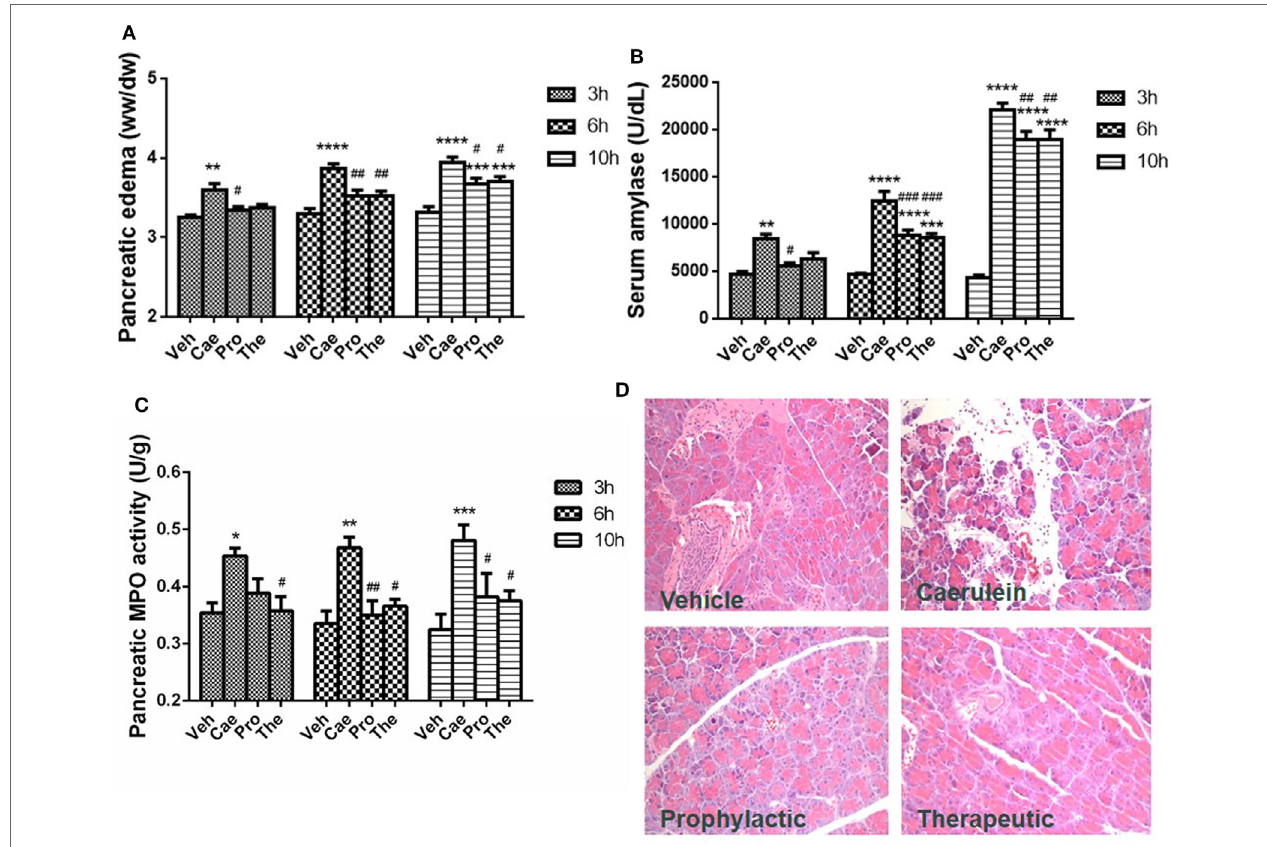
FigUre 1 | Prophylactic or therapeutic lactose treatment mitigates the severity of experimental acute pancreatitis in a time-related manner. Pancreatic edema (a) and serum amylase (B) , pancreatic myeloperoxidase activity (c) , and pancreatic histology (D) were determined. Vehicle (Veh): saline treatment. Caerulein (Cae): caerulein hyperstimulation treatment. Prophylactic: lactose administered 30 min before starting caerulein treatment. Therapeutic (The): lactose administered 1 h after starting caerulein treatment. Data are mean ± SEM from at least three independent experiments of six to eight independent mice in each group. * p < 0.05, ** p < 0.01, *** p < 0.001, **** p < 0.0001 vs. corresponding Veh by two-way analysis of variance (ANOVA); # p < 0.05, ## p < 0.01, ### p < 0.001 vs. corresponding Cae by two-way